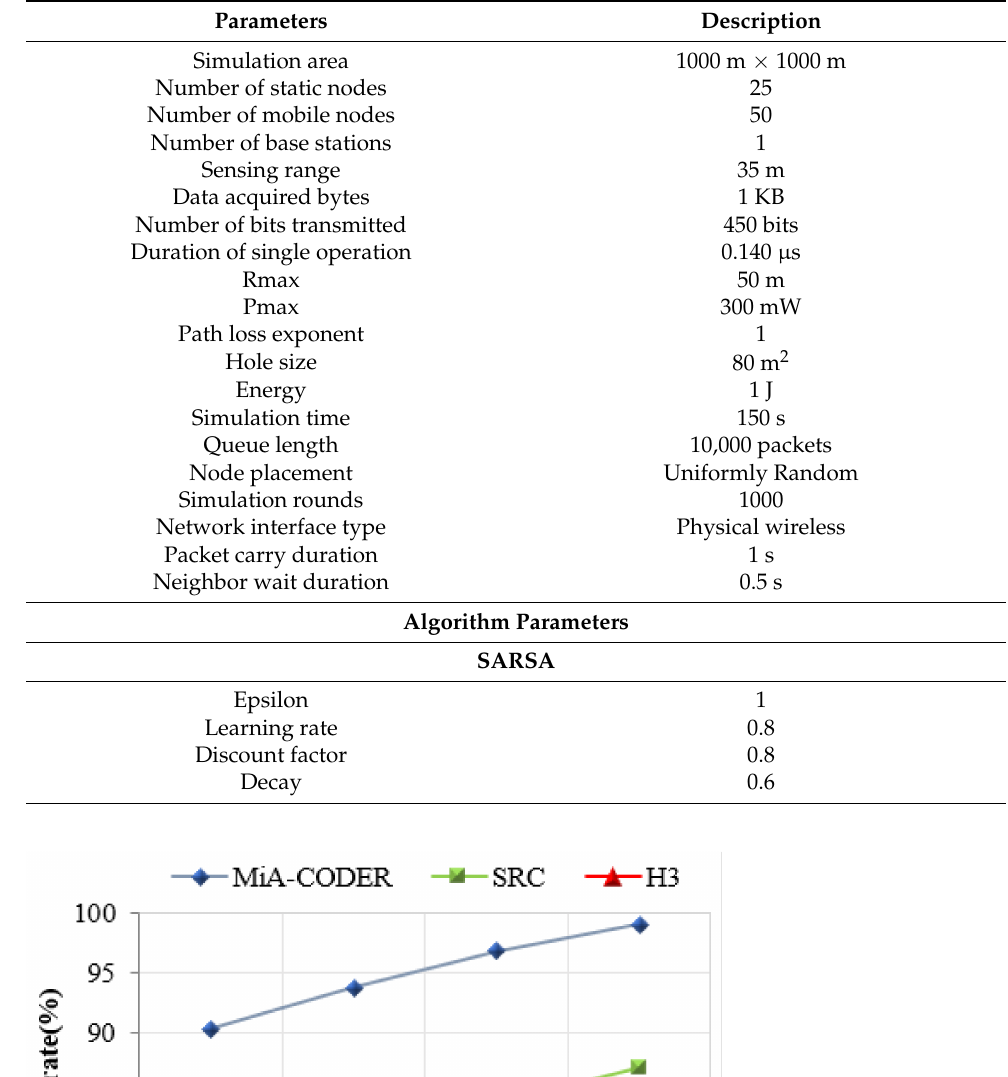
Table 5. Simulation parameters.